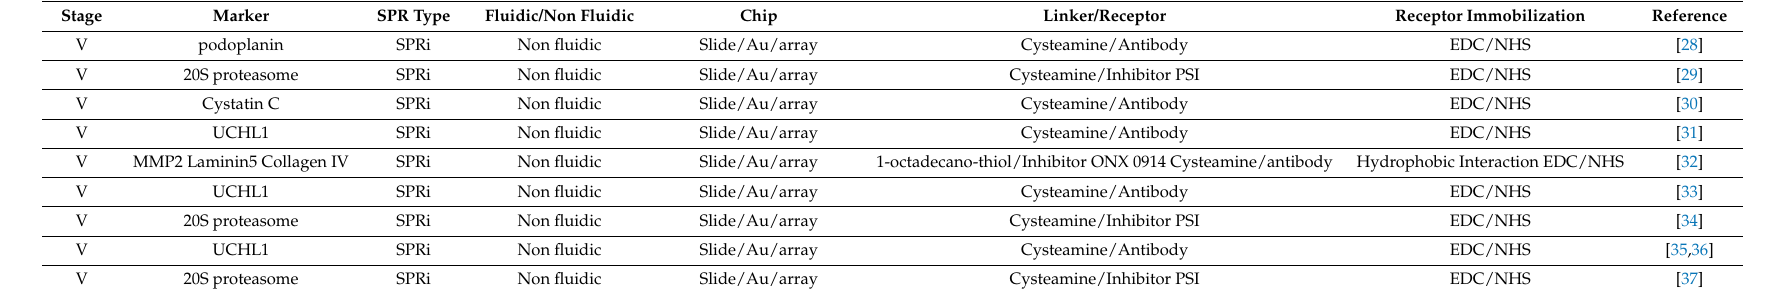
Table 3. Technical solutions for developed biosensors applied in clinical